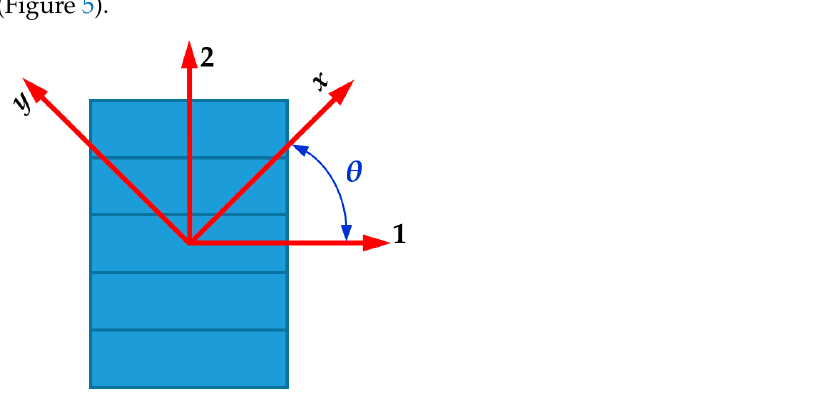
Figure 5. Layered composite element: 1-the direction along the fiber; 2-the direction transverse to the fiber.